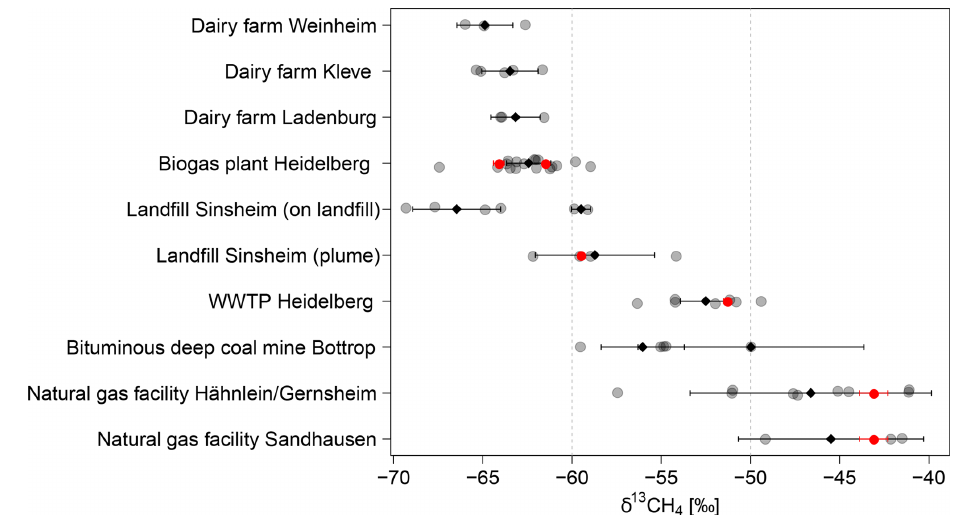
Figure 9. δ 13 CH 4 signature of CH 4 sources. Each determined δ 13 CH 4 signature is shown as a grey dot. The black diamond-shaped points show the average δ 13 CH 4 signature with the standard deviation. The δ 13 CH 4 signatures measured from gas samples taken at the different sites are plotted as red points. For both natural gas facilities, it was not possible to take direct samples. Here the red points indicate the mean δ 13 CH 4 signature of natural gas in Heidelberg measured between end of 2016 and November 2018 as described in this